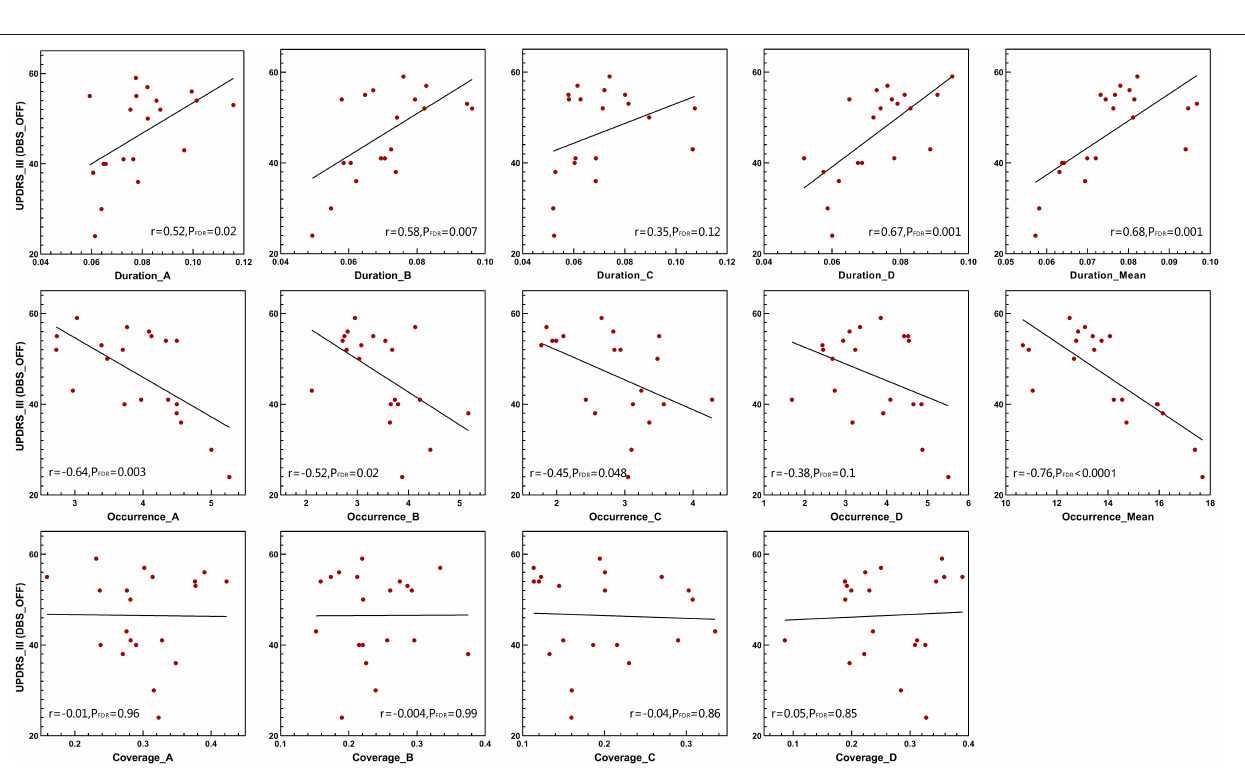
Frontiers in Neuroscience |